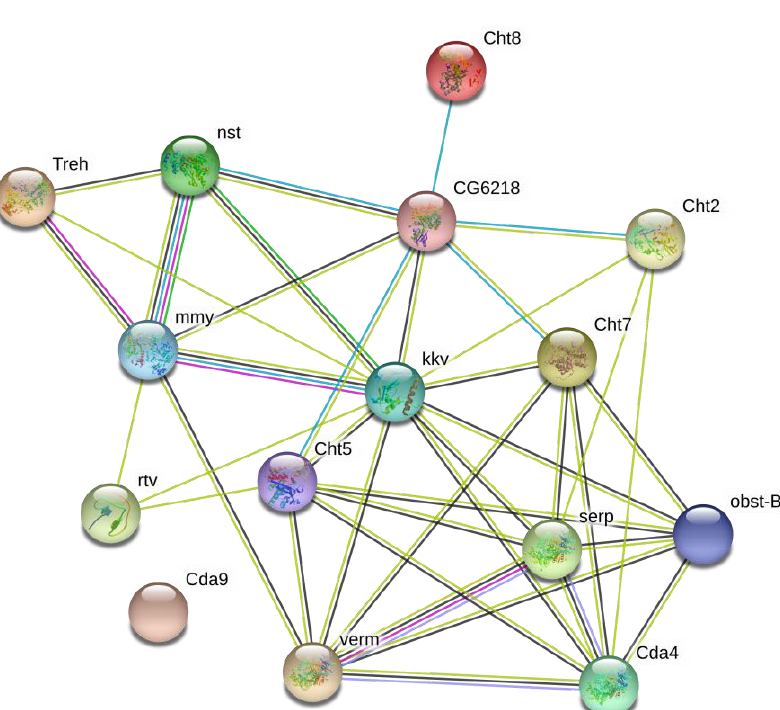
Figure 4. Prediction of protein–protein interaction networks of chitin metabolism-related enzymes based on the STRING website using the D. melanogaster database. The homologue of GpCDA1 in D. melanogaster is serp, as GpCDA2 corresponds to verm; GpCDA4 corresponds to Cda4; GpCDA5 corresponds to Cda9; GpCHT1 corresponds to Cht5; GpCHT2a corresponds to Cht2; GpCHT2b and GpCHT-h correspond to Cht8; GpCHT3a corresponds to obst-B; GpCHT3b has no homologue; GpCHT7 corresponds to Cht7; GpCHSA and GpCHSB correspond to kkv; GpNAGK and GpCHSB correspond to CG6218; GpUAP corresponds to CG6218; GpPAGM corresponds to nst; GpRtv corresponds to rtv; GpTre1 and GpTre2 correspond to Treh. Table 3. Unigenes potentially involved in the detoxification of G.